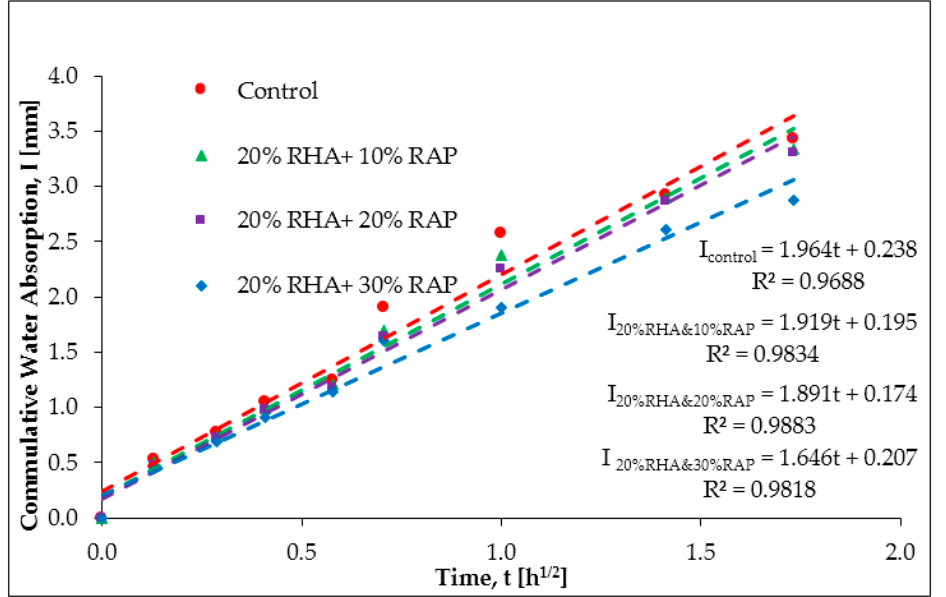
Figure A6. Cumulative water absorption by 20% RHA and (10–30) % RAP-inclusive concrete.